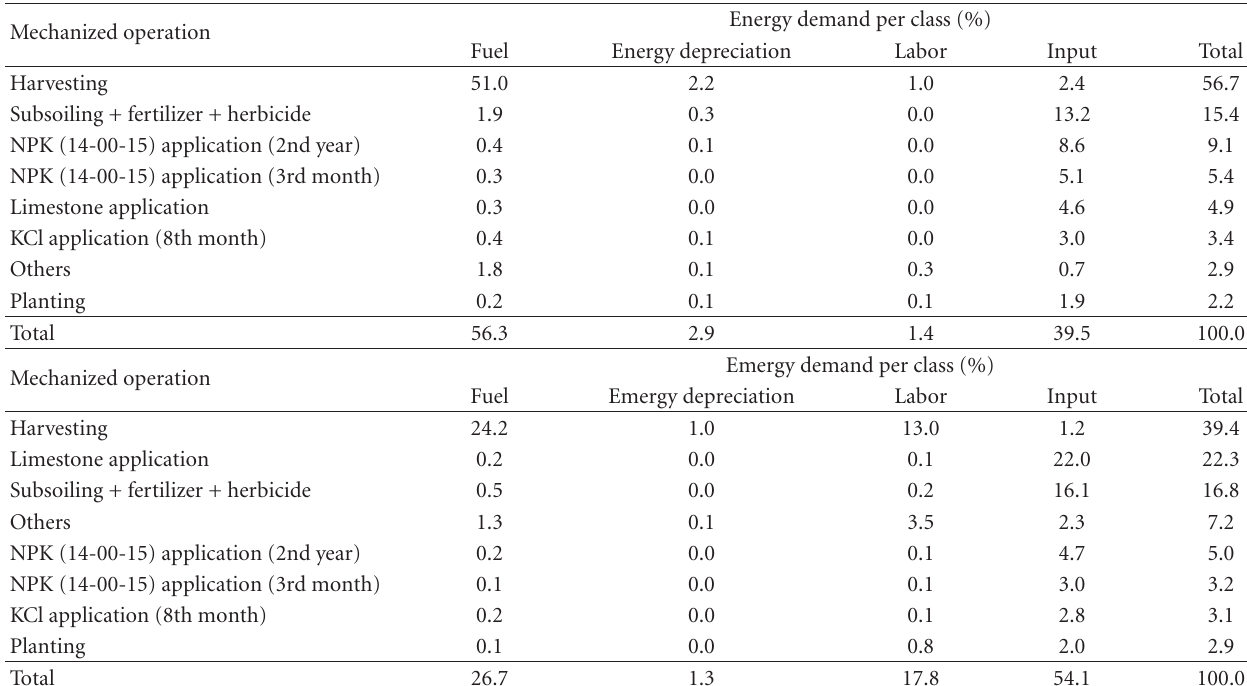
Table 5: Energy and emergy demand per class for the mechanized operations.